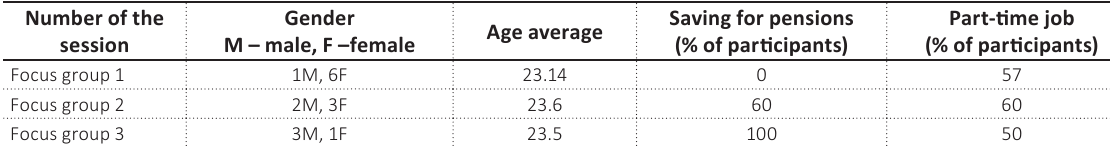
Table 1. Characteristics of participants in each focus